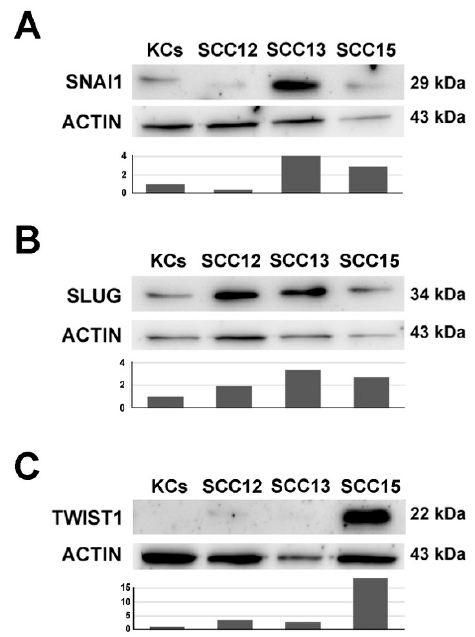
Figure 2. Immunoblotting of SNAI1 (Panel A ), SLUG (Panel B ) and TWIST (Panel C ) proteins expression in healthy keratinocytes and SCC cell lines (29 kDa, 34 kDa and 22 kDa respectively). The plot below indicates the normalized densitometric analysis of immunoblot.